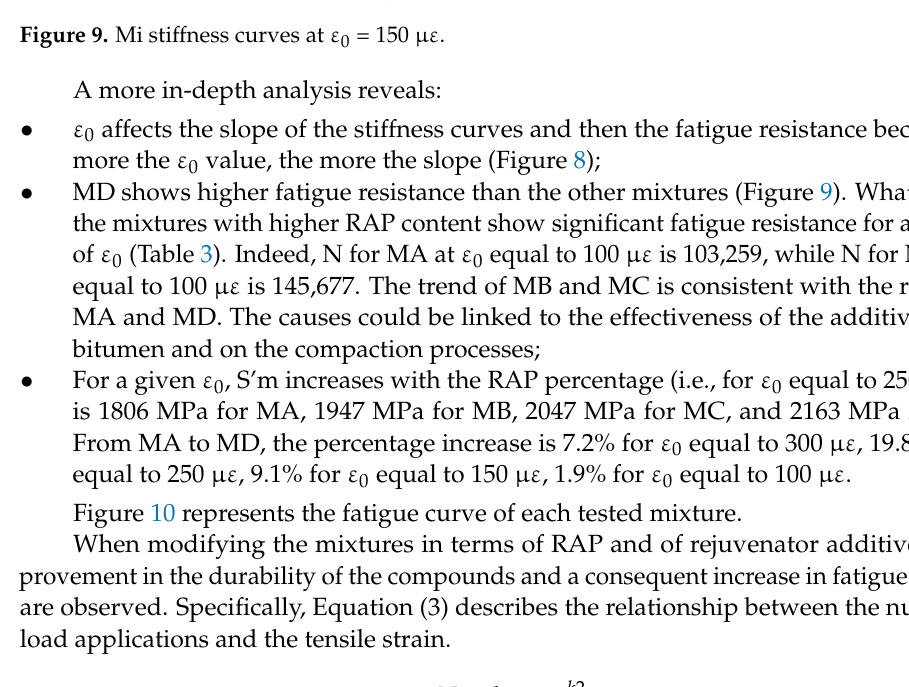
Figure 10 represents the fatigue curve of each tested